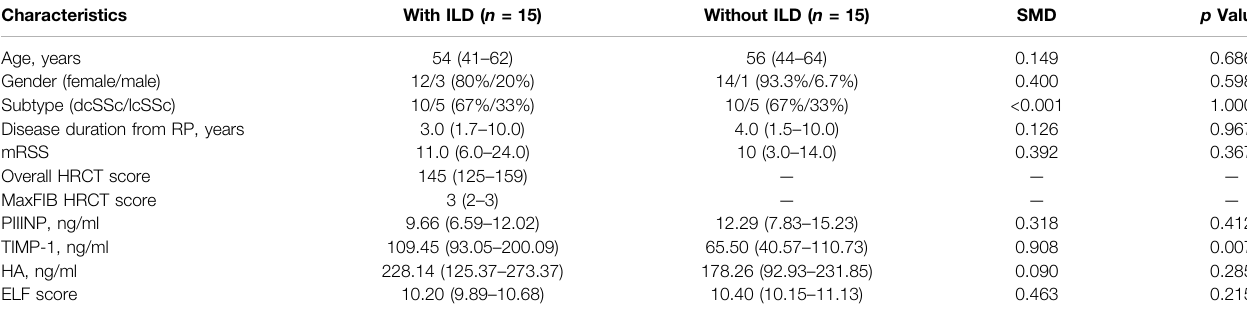
TABLE 5 | Clinical and serological parameters of SSc patients with and without ILD matched by propensity score matching. Characteristics With ILD ( n = 15)